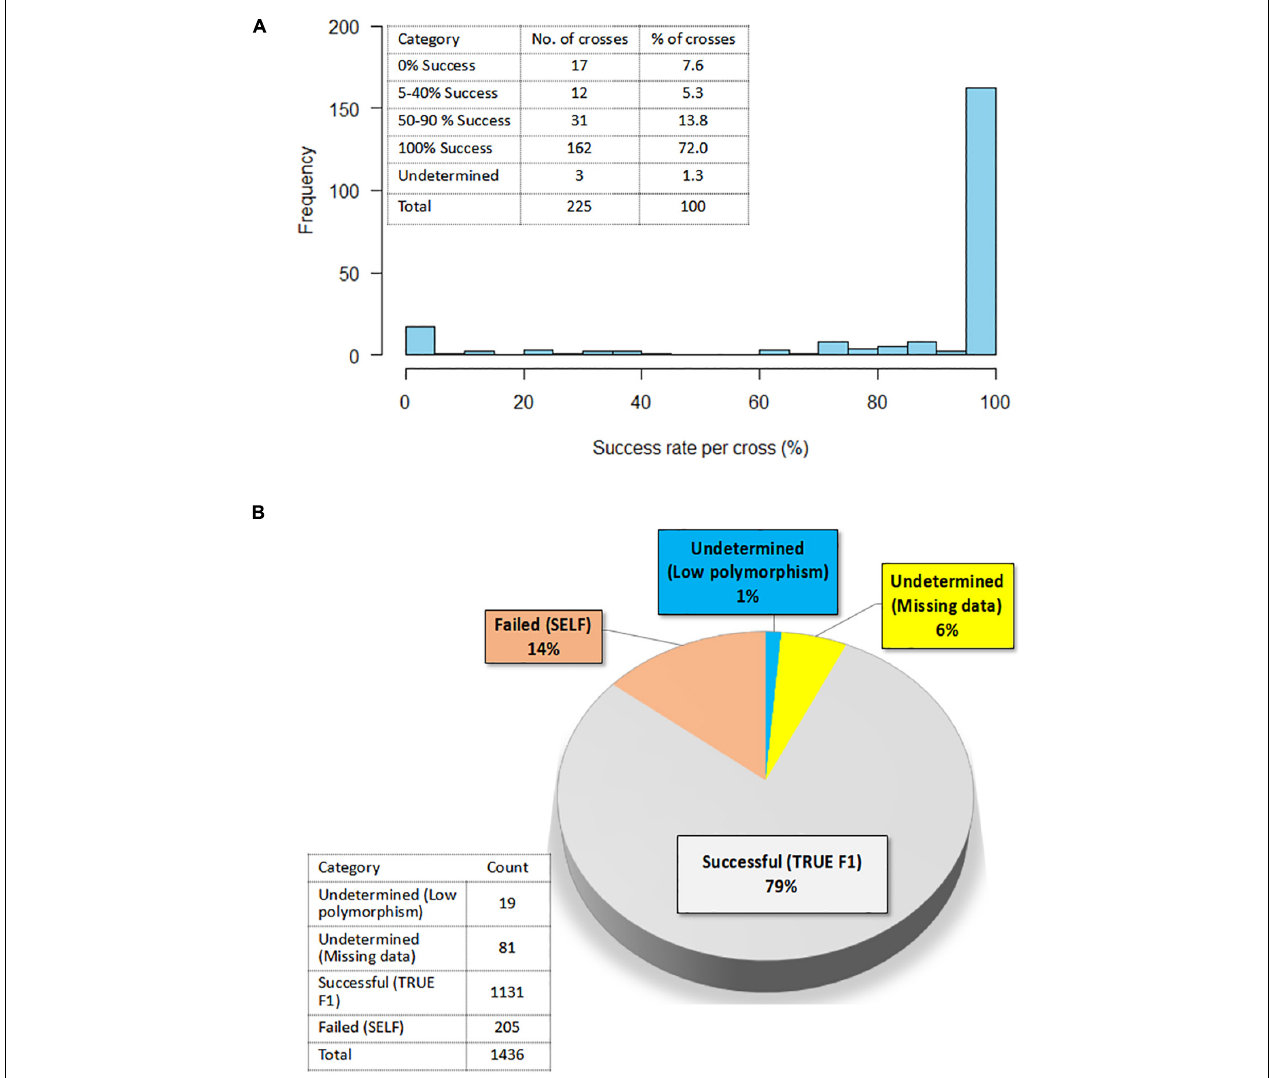
FIGURE 8 | Confirmation of hybridity. (A) Histogram showing the distribution of success rate for true F 1 hybrids in 225 crosses; Insert on the top left shows the exact number of crosses and a corresponding percentage in each success category (B) Pie chart depicting percentage of true F 1 s out of 1,436 F 1 progenies as determined by the level of heterozygosity of F 1 progenies for the polymorphic SNP markers; Insert on the left-hand bottom corner reflects the actual numbers of F 1 progenies in each